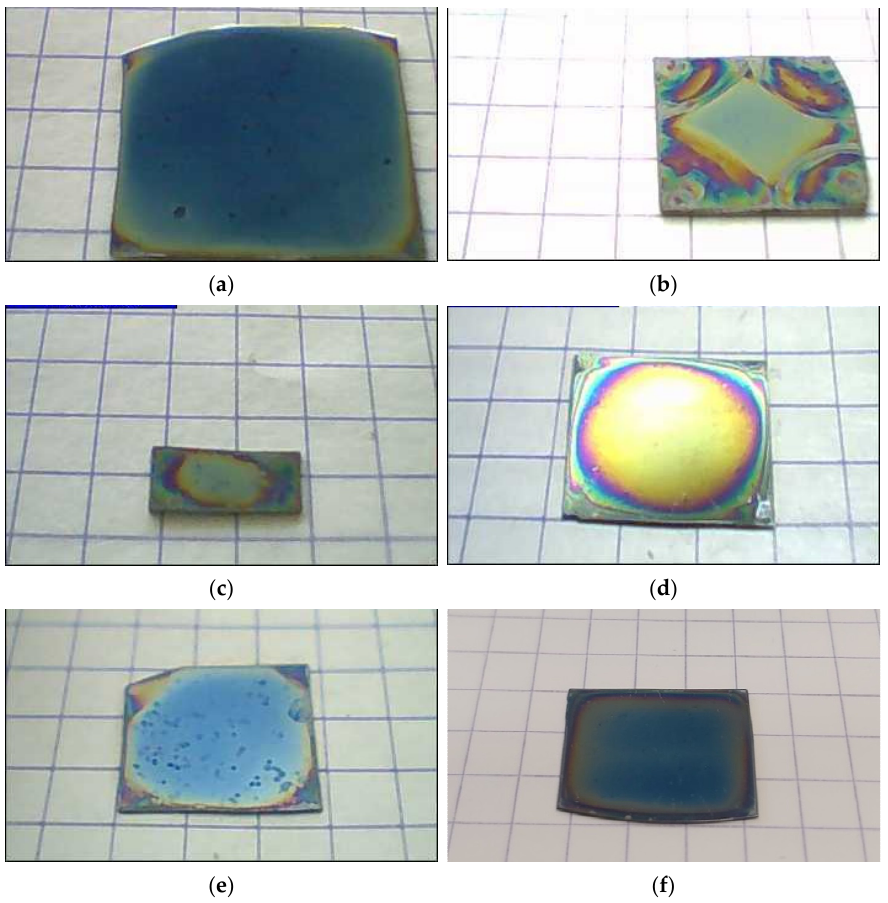
Figure 2. Photographs of some representative sol-gel spin-coated ZnO samples: deposited in standard conditions ( a ), with reduced rotation speed of 1000 rpm ( b ), with reduced size of 5 mm × 10 mm ( c ), using a high concentration [ZnAc] = 1 mol/L ( d ), using a high MEA content r = 2 ( e ) and using ethanol as solvent ( f ). Except for case ( c ), all other samples have a size of about 20 mm × 20